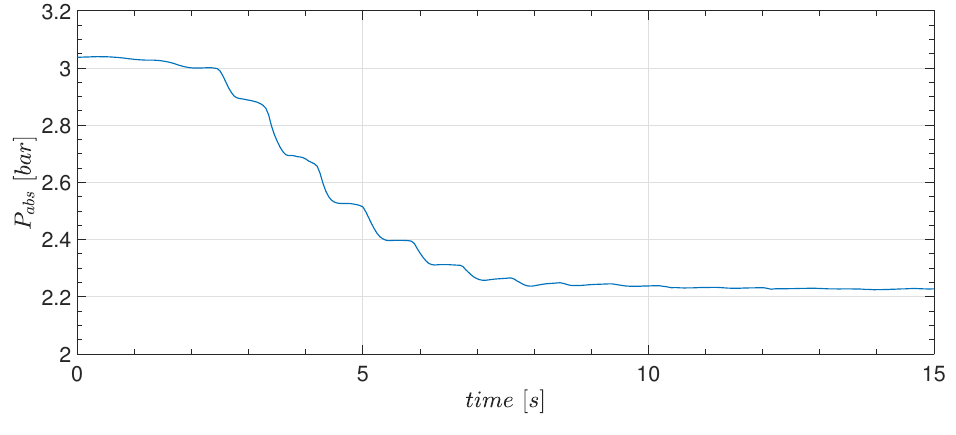
Figure 9. Absolute pressure in case 3